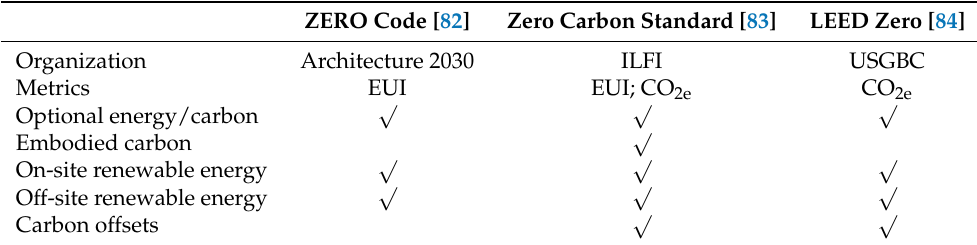
Table 5. Major aspects involved in ZCB codes and